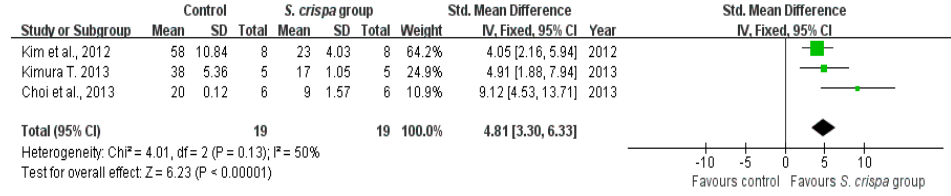
Figure 5. Comparison of levels of tumor activity between control and S. crispa groups. ( individual studies; (  ): summary SMDs of the comparison. Figure 10. Comparison of oxidative inhibitory capacity between control and S. crispa groups. (